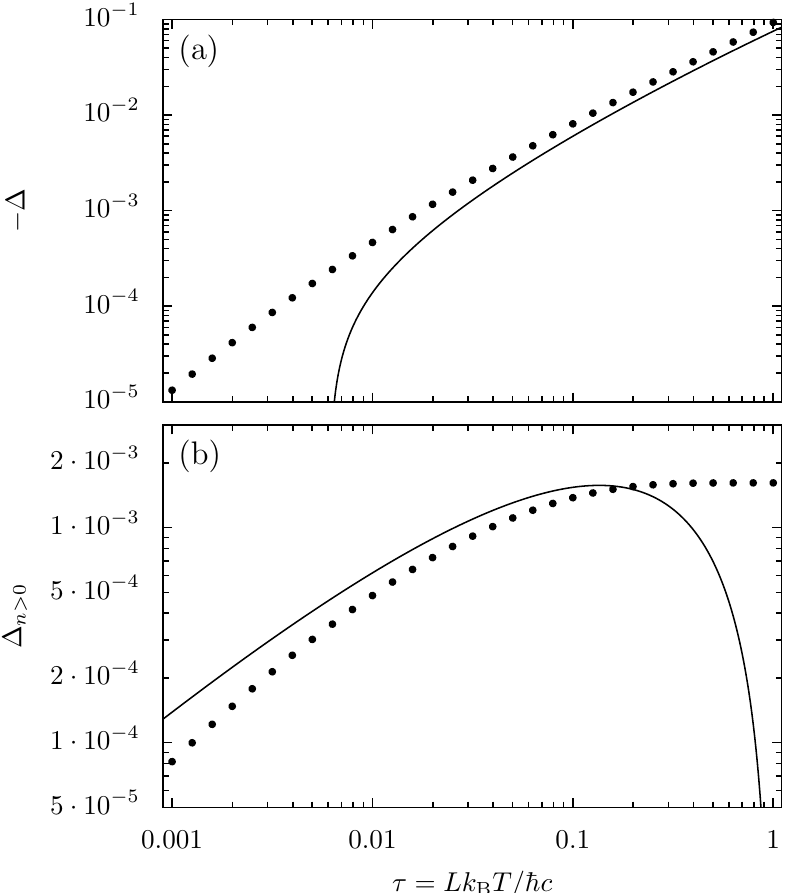
Figure 3. Relative thermal correction (62) of the Casimir free energy as a function of temperature for a geometrical aspect ratio of x = L / R = 10 − 3 . ( a ) The dots represent the numerically exact full Matsubara sum and the line corresponds to the analytical asymptotic expansion (63). Note that the correction ∆ is negative. ( b ) Contribution ∆ n > 0 of the positive Matsubara frequencies n > 0. The dots again represent the numerically exact result while the line corresponds to the analytical asymptotic expansion derived from (59). For n > 0, the correction to the PFA result is